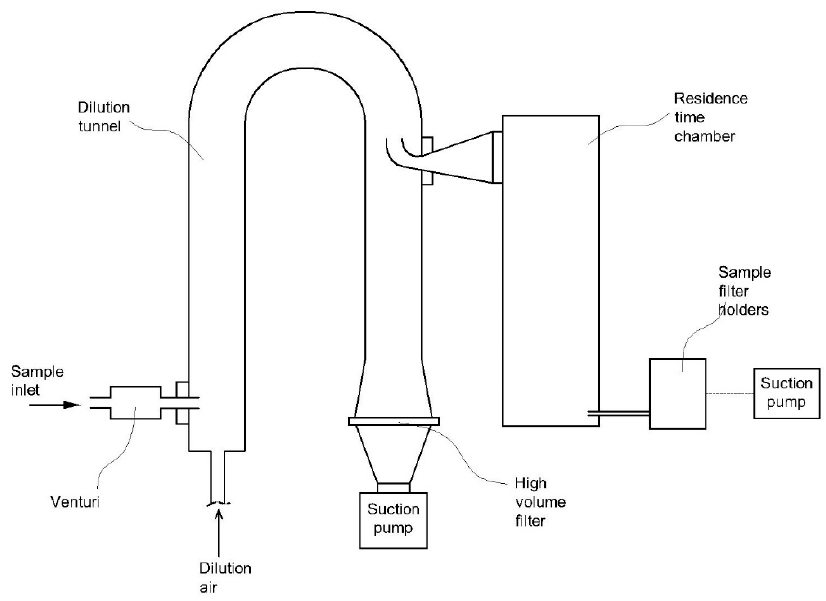
Figure 9. Dilution system invented by Hildemann et al. [110].